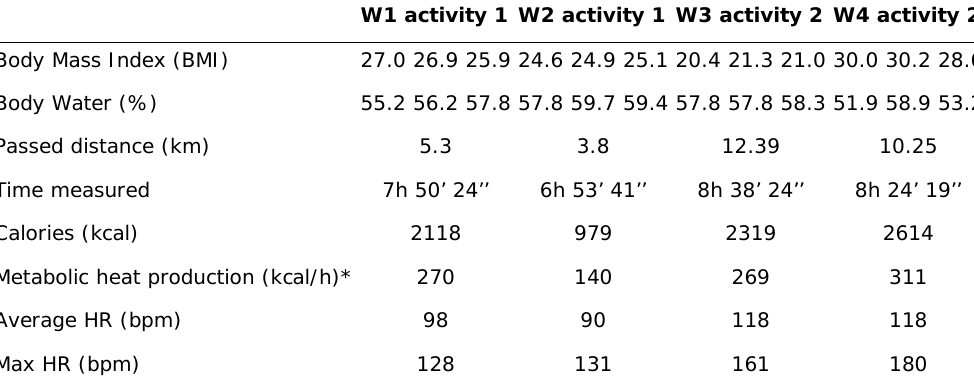
Table 4. Main data gathered from daily working